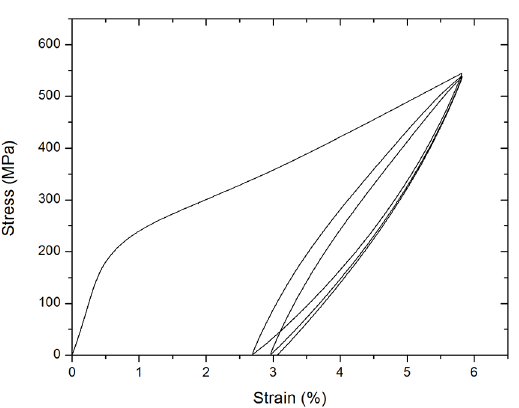
Figure 4. Test for quantification of superelasticity at 0 ºC with 3 cycles of strain for Cu-11.8Al-0.6Be-0.5Nb (wt.%) alloy.